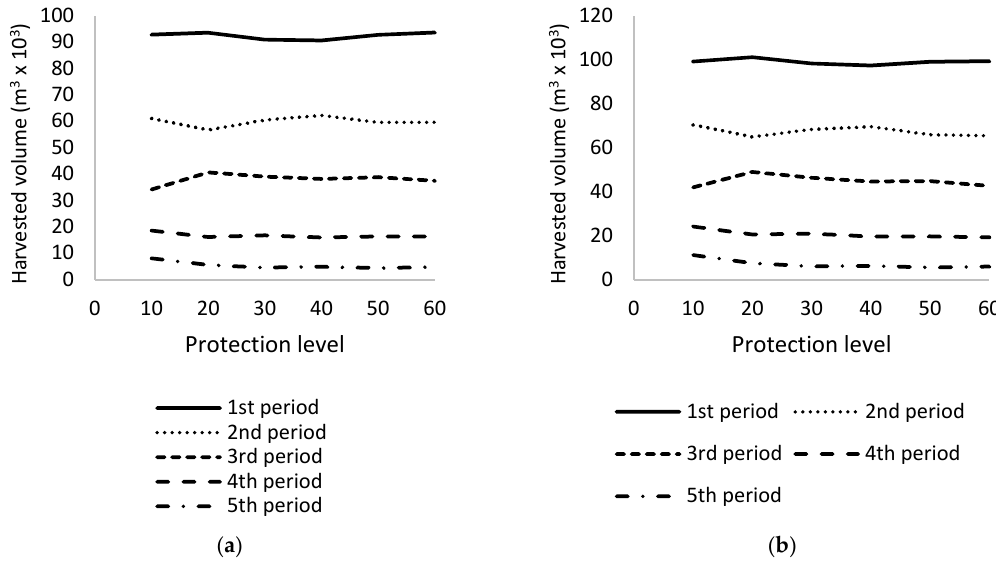
Figure 2. The relation between the protection level and the harvested volume obtained by the robust (ROB) model ( a ) and simulation experiments ( b ) for each period. Table 3. The resulting gap tolerance for instances of the ROB model.